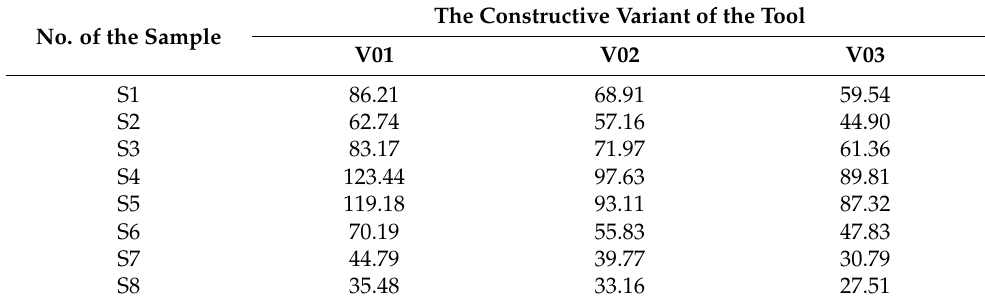
Table 4. The medium values of the F c component for the 3 variants of cutting tools, daN. No. of the